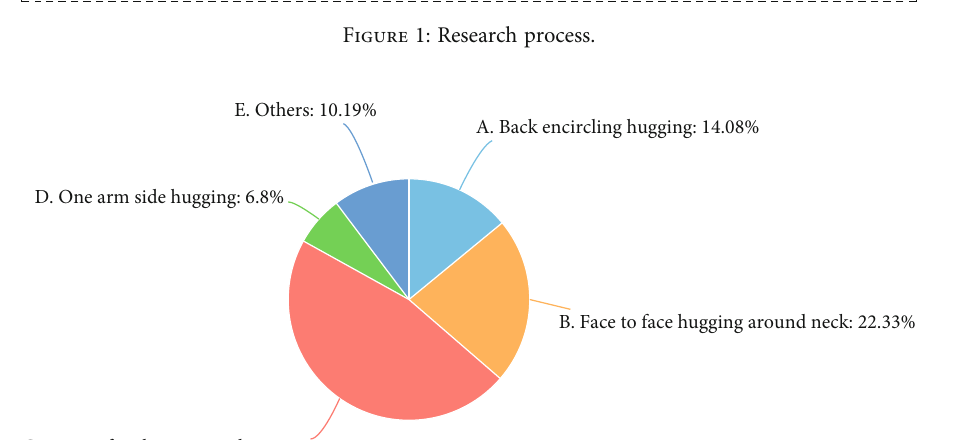
Figure 1: Research process.